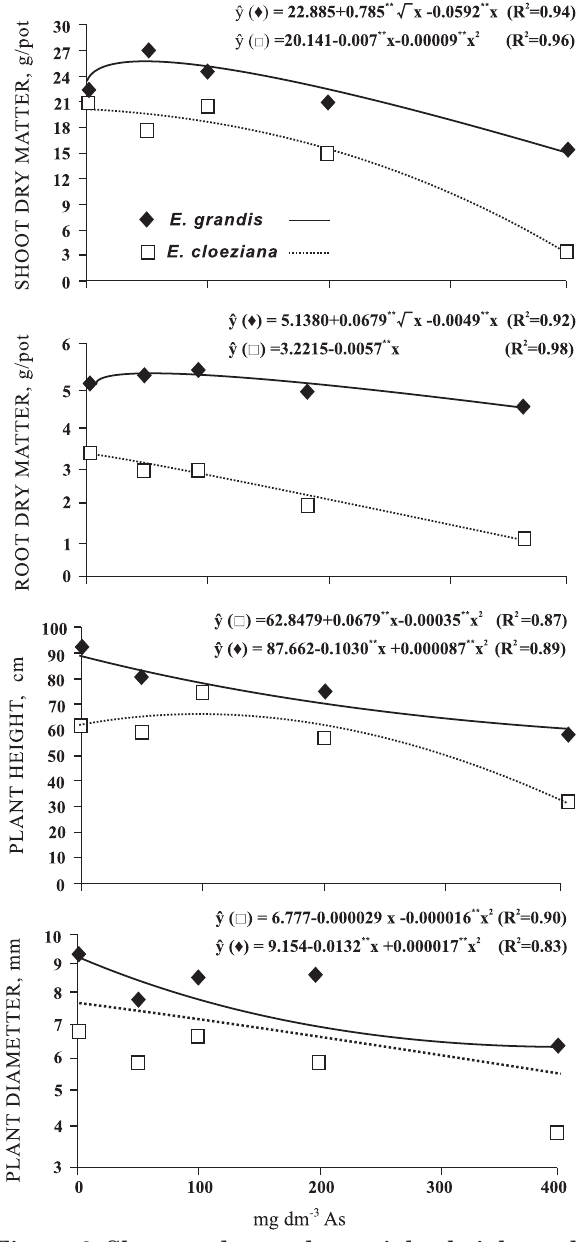
Figure 2. Shoot and root dry weight, height and diameter of E. grandis and E. cloeziana seedlings treated with As doses. * significant and ** significant effect at 5 and 1 % probability by the F test,